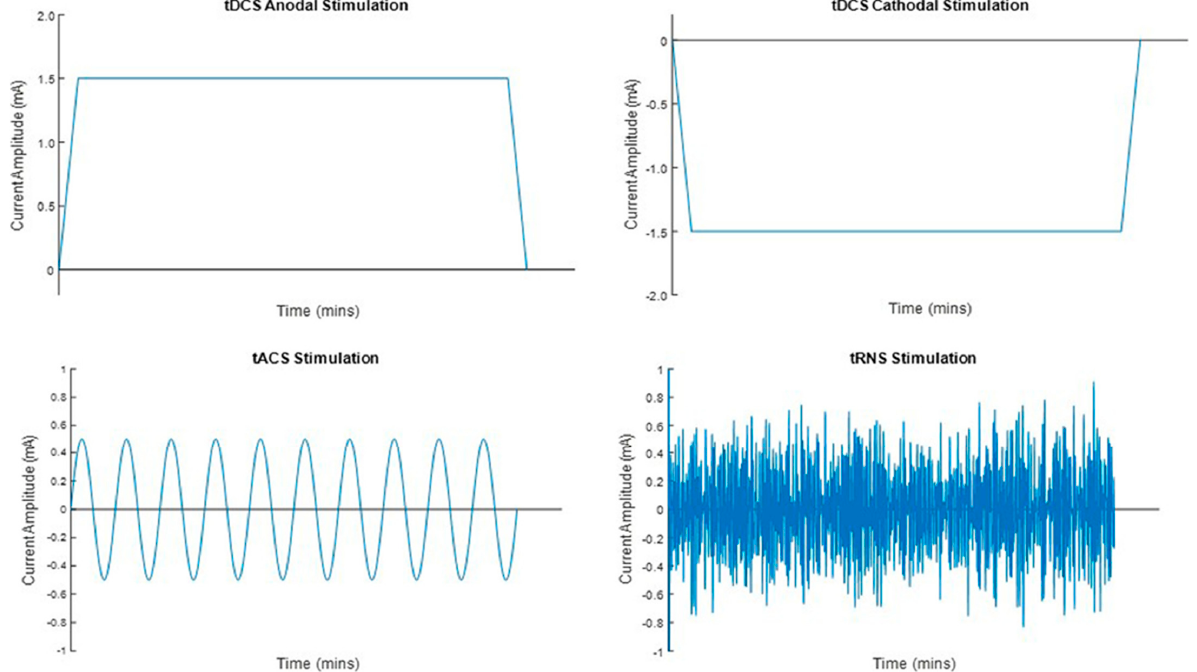
Figure 2. Stimulation waveforms for transcranial direct current stimulation (tDCS) (anodal and cathodal), transcranial alternating current stimulation (tACS), and transcranial random noise stimulation (tRNS). Reproduced from reference [59], https://doi.org/10.1007/s10545-018-0181-4, under the terms of the CC BY 4.0 license, http://creativecommons.org/licenses/by/4.0/ (accessed on 29 March 2022). tACS is a still unexplored (and less used) tES. It generates an alternating current at a specific frequency (Figure 2), with the potential to synchronize or desynchronize activity between targeted brain regions through phase-locking and coherence mechanisms [60]. During a half cycle of stimulation, one electrode will function as an anode and the other one as a cathode, and current strength will increase and decrease following a half-sine wave. During the other half cycle, the pattern will reverse (the former anode should be